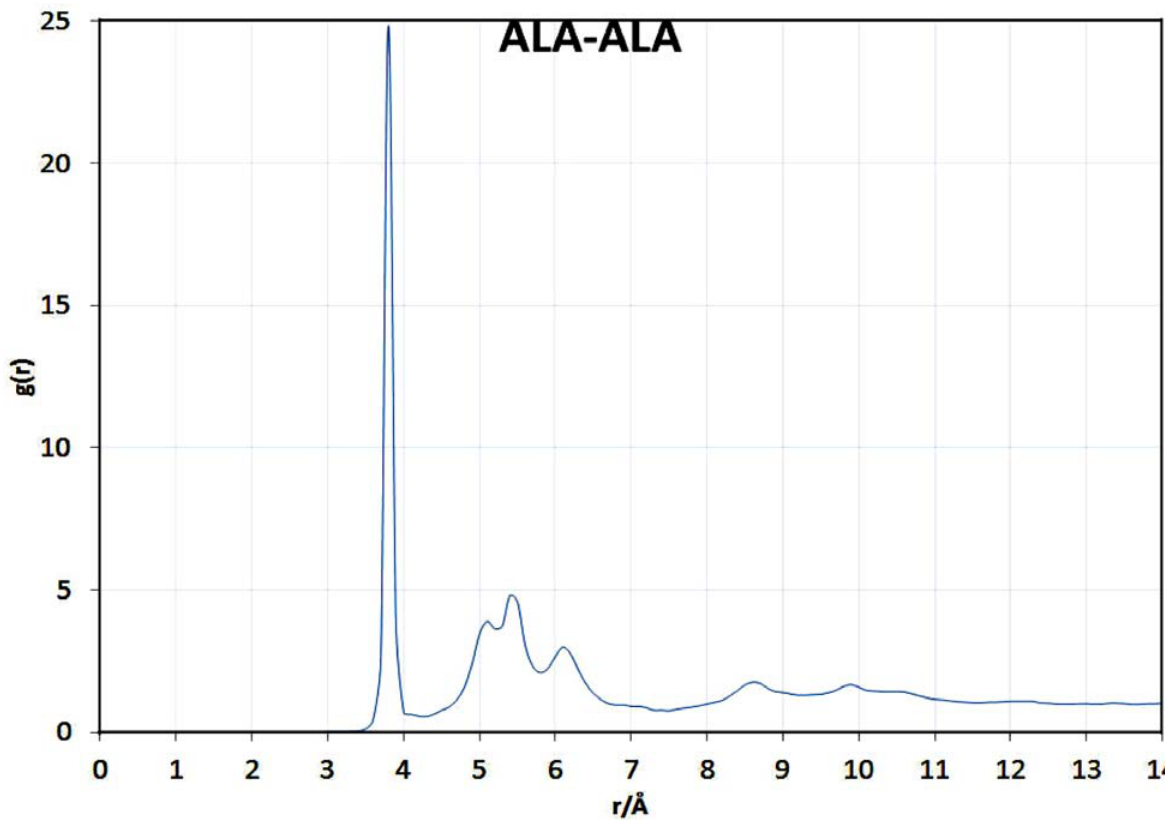
Figure 2. Radial distribution function for two alanine molecules.